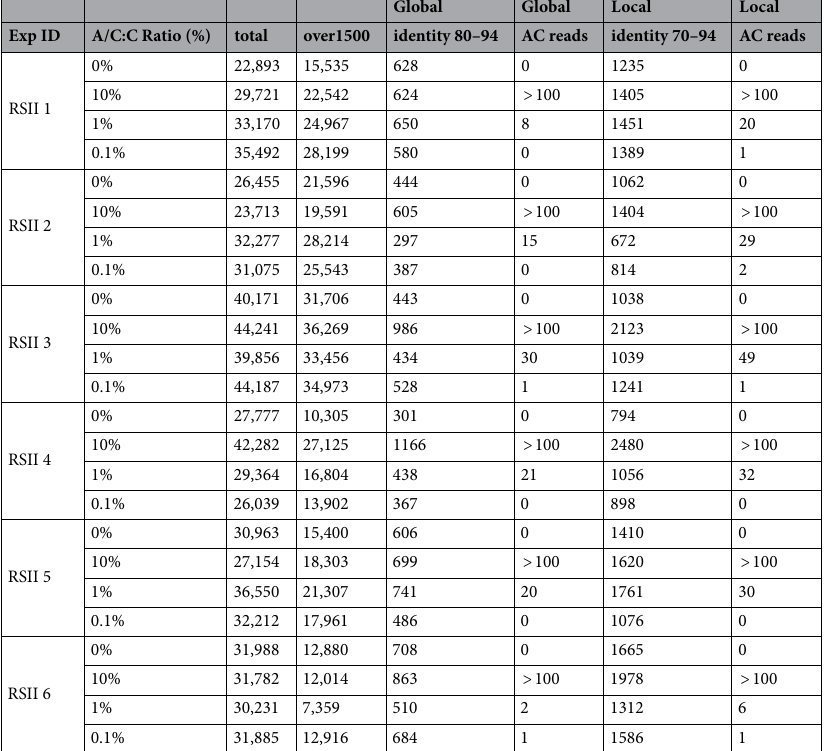
Table 1. Summary of the number of reads from the NGS